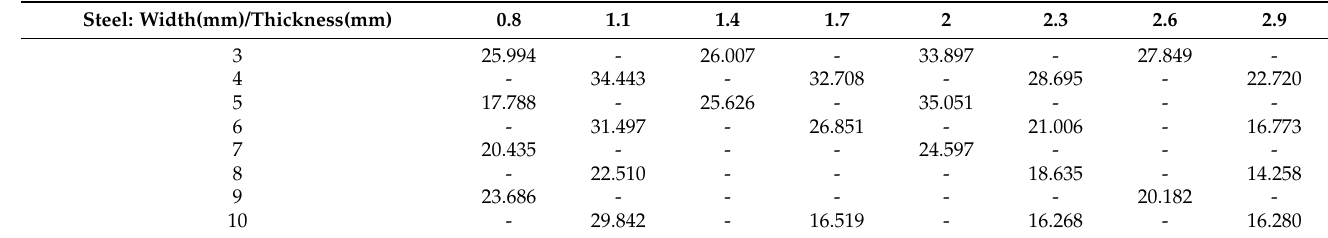
Table 3. Steel material specific energy absorption